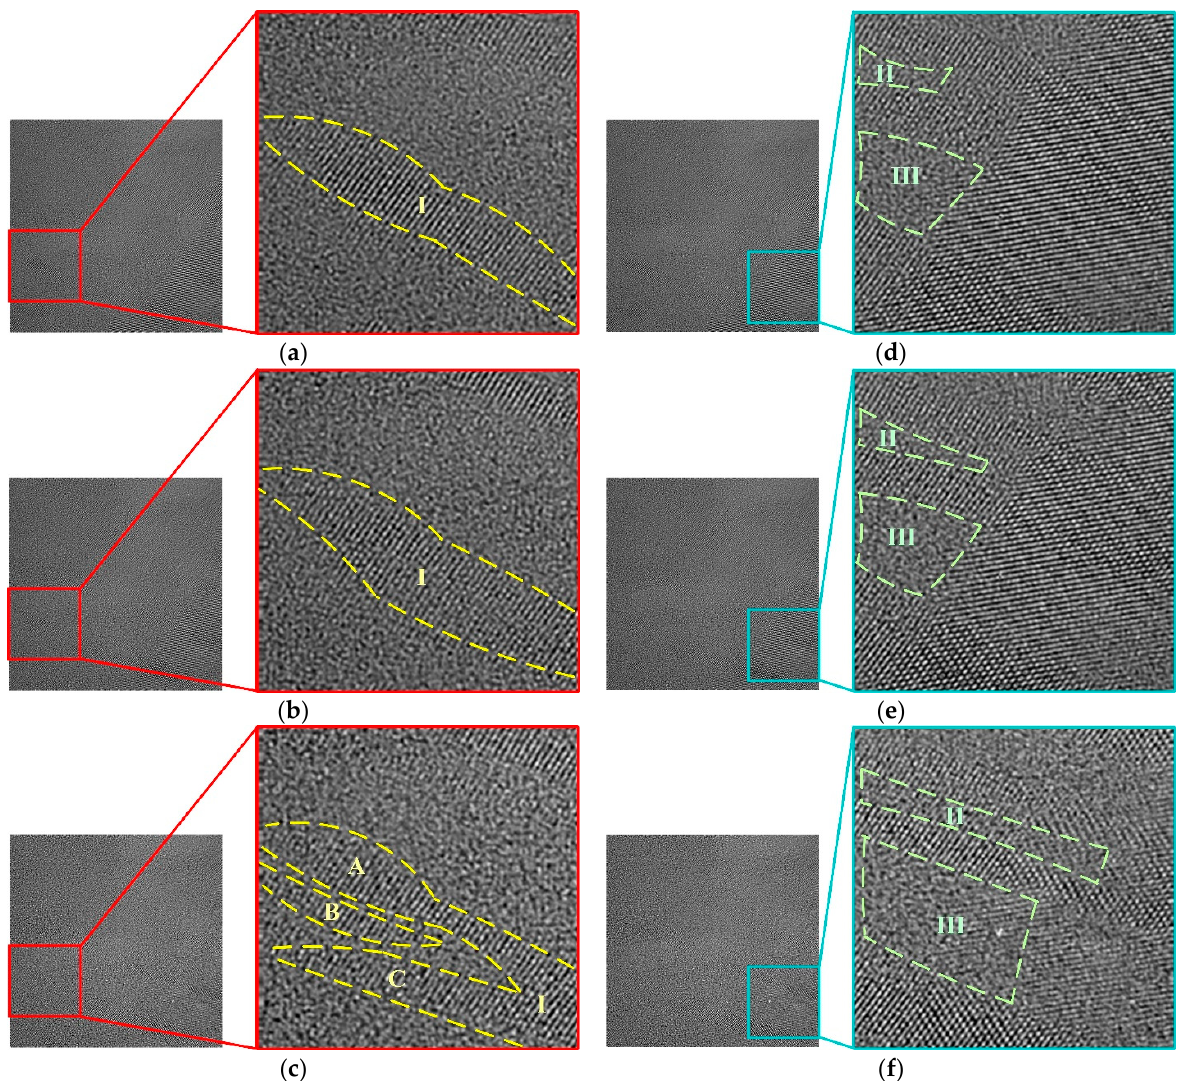
Figure 7. Grain-boundary evolution under electron irradiation at different doses: ( a ) zoom in area I before electron irradiation; ( b ) zoom in area I at 280 krad; ( c ) zoom in area I at 398 krad; ( d ) zoom in area II and III before electron irradiation; ( e ) zoom in area II and III at 280 krad; ( f ) zoom in area II and III at 398 krad.